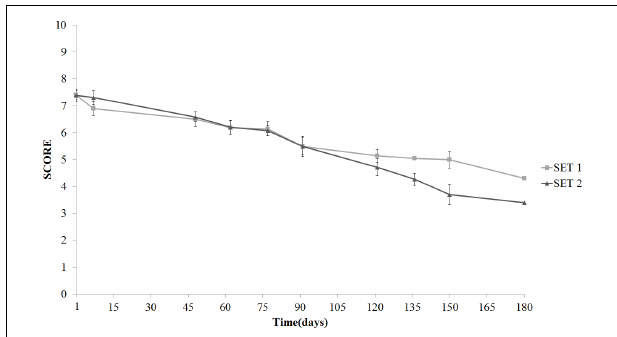
FIGURE 10 | Evolution of the overall sensory quality in Spanish-style olives packaged in PTE bags and stored at 4 ◦ C: SET1 (bio-preserved), and SET2 (control). Means and standard deviations were obtained from measurements made in duplicate packages from two different experiments ( n =